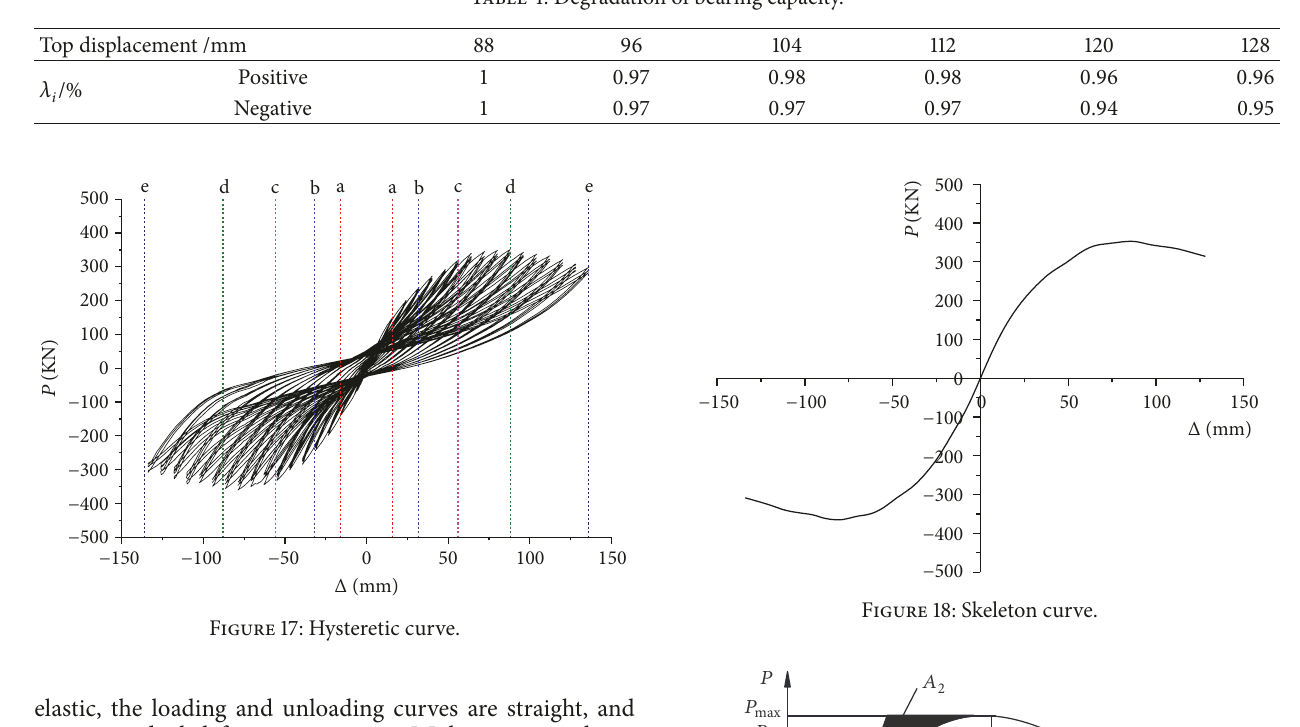
Table 4: Degradation of bearing capacity.